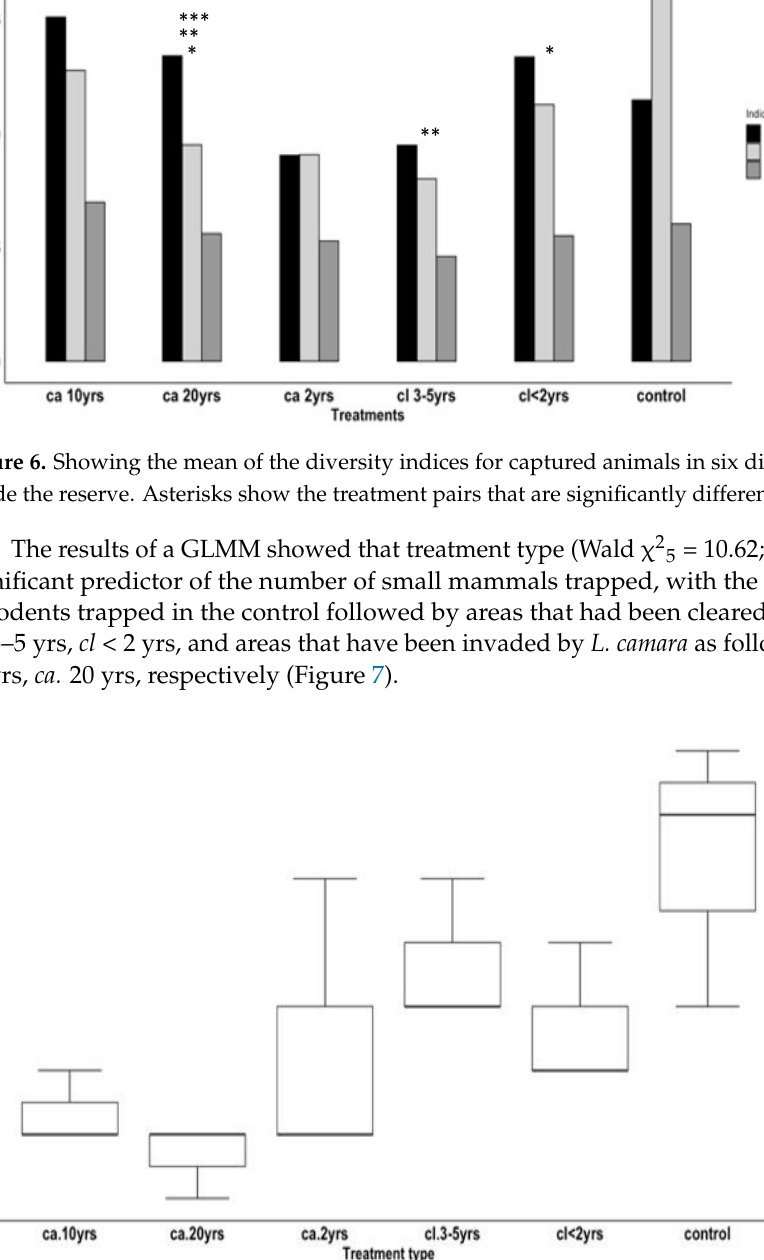
Table 5. The output of a GLMM model showing species richness by treatment types. Significant values are indicated by an asterisk.